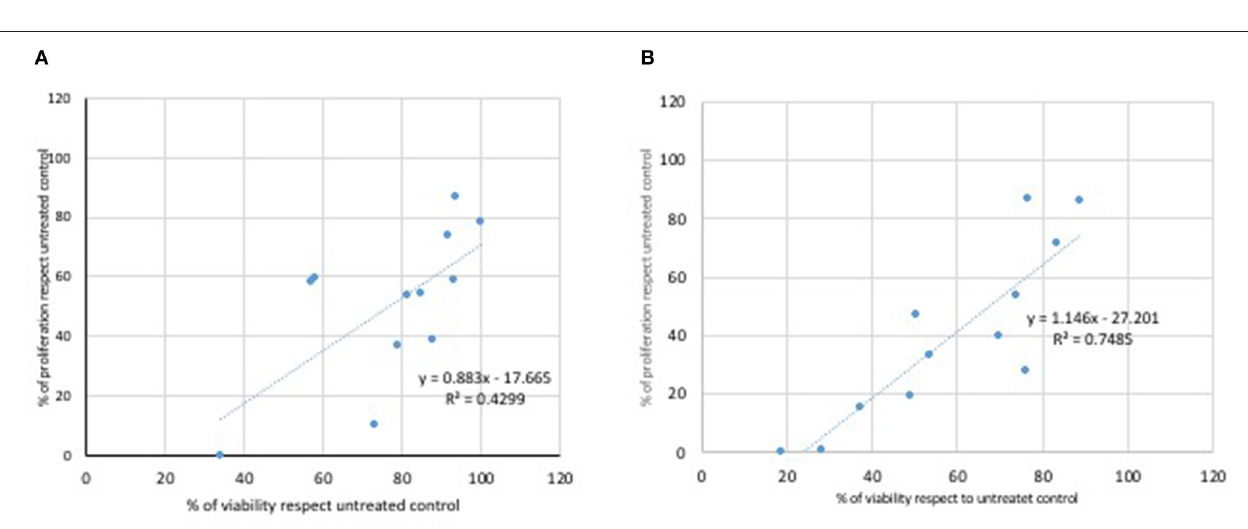
FIGURE 6 | Correlation between MTT and Trypan Blue test for Caco2 cells treated with different doses of Glyphosate (A) and Roundup (B) . Both correlations were statistically significant at P < 0.05.